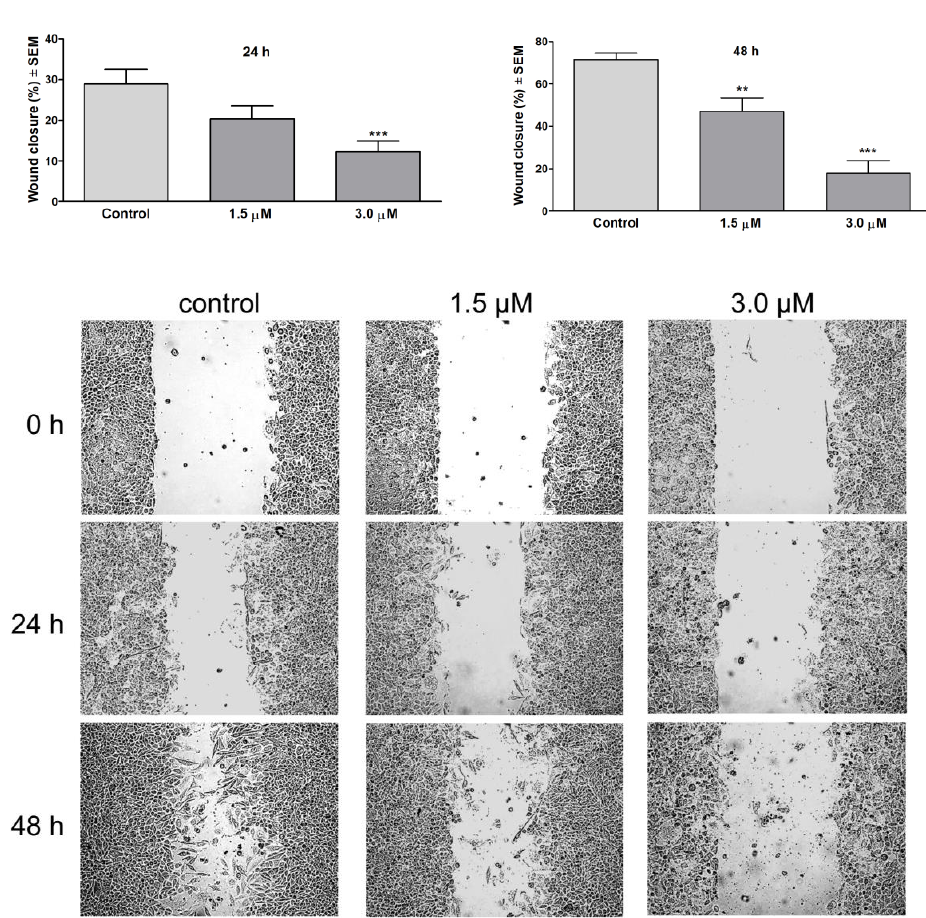
Figure 16. Effect of compound 6 on the migration of SiHa cancer cells after 24 and 48 h of incubation (left and right upper panels, respectively). ** and *** indicate p < 0.01 and p < 0.001, respectively, by means of one-way ANOVA followed by Dunnett’s post-hoc test. Wound healing assay. Lower panel: representative images of reduced wound healing at 0, 24 and 48 h post-treatment.